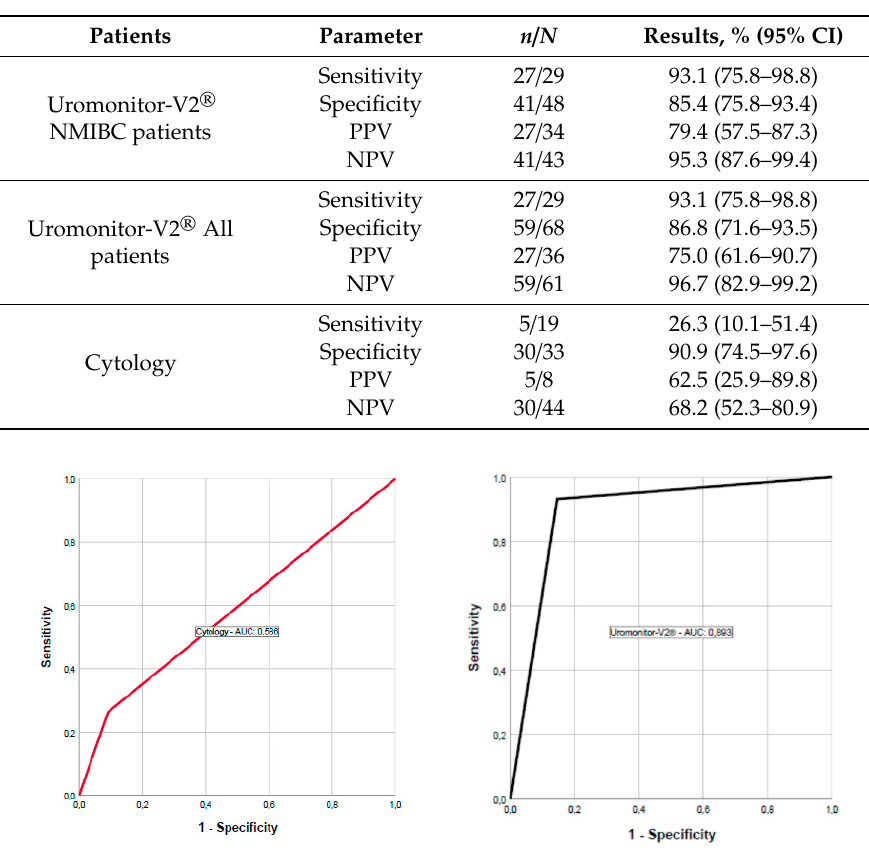
Table 3. Comparing Uromonitor-V2 ® test characteristics with urine cytology.